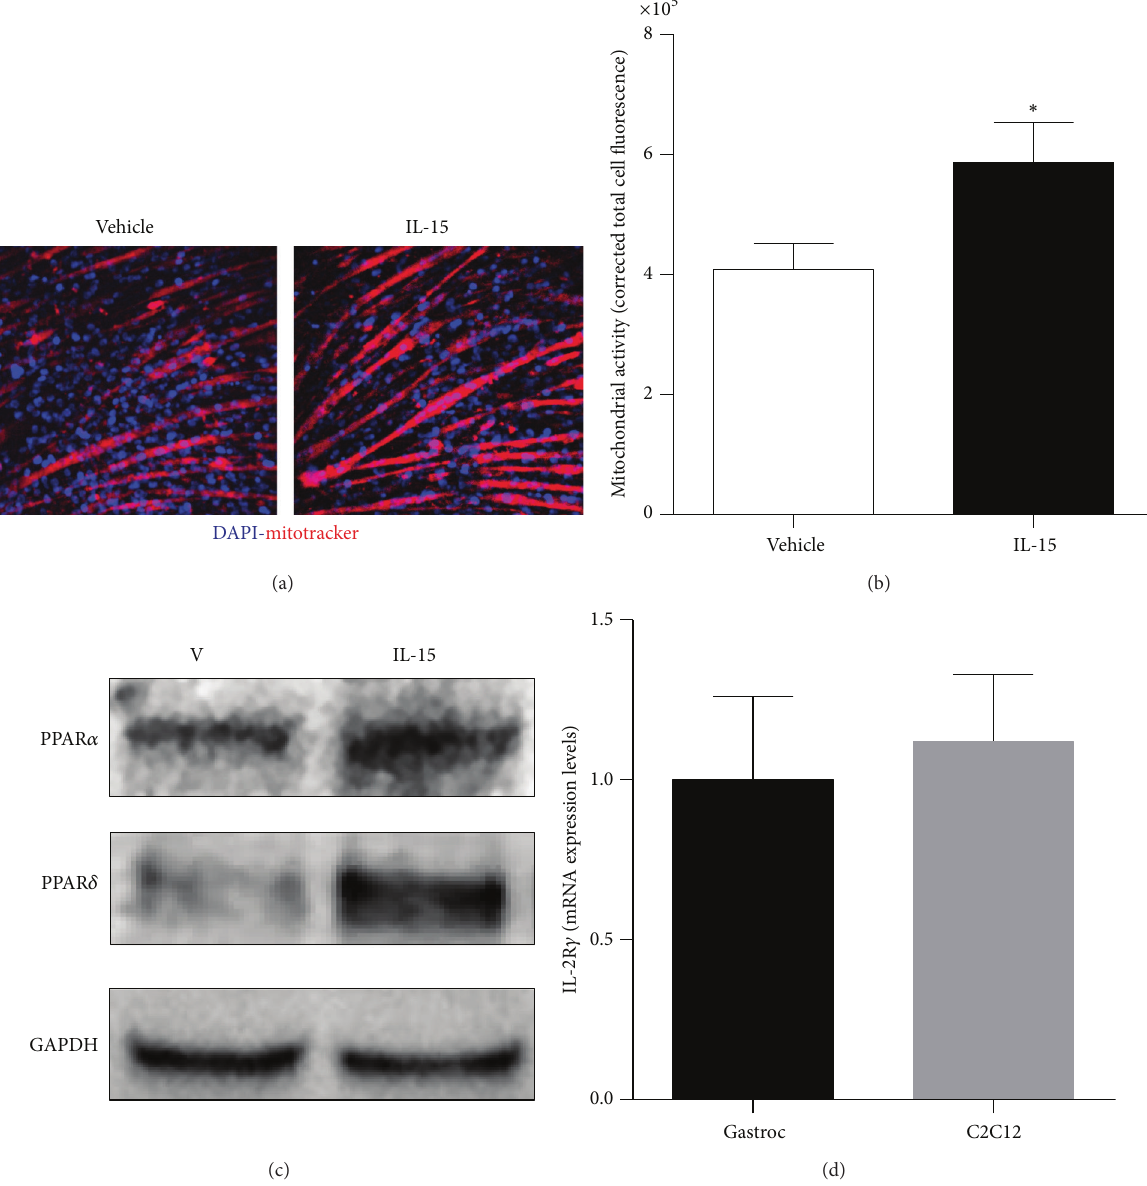
Figure 1: Effect of IL-15 signaling on mitochondrial activity. (a) Representative images of mitochondrial activity assessment in live cells using a fluorescent probe sequestered into active mitochondria; (b) quantifiable fluorescence corrected for myotube size; (c) western blot of PPAR 𝛼 and PPAR 𝛿 protein expression; (d) mRNA expression of IL-2R 𝛾 . Assessments were carried out on differentiated C2C12 myotubes following treatment with 100ng/mL of IL-15 every other day for 6 days during the differentiation protocol. Image J was used to quantify cell fluorescence. GAPDH was used as control for protein and mRNA expression assessments. All values are displayed as mean ± SEM, 𝑛 = 3–6 per group, ∗ 𝑃 < 0.05